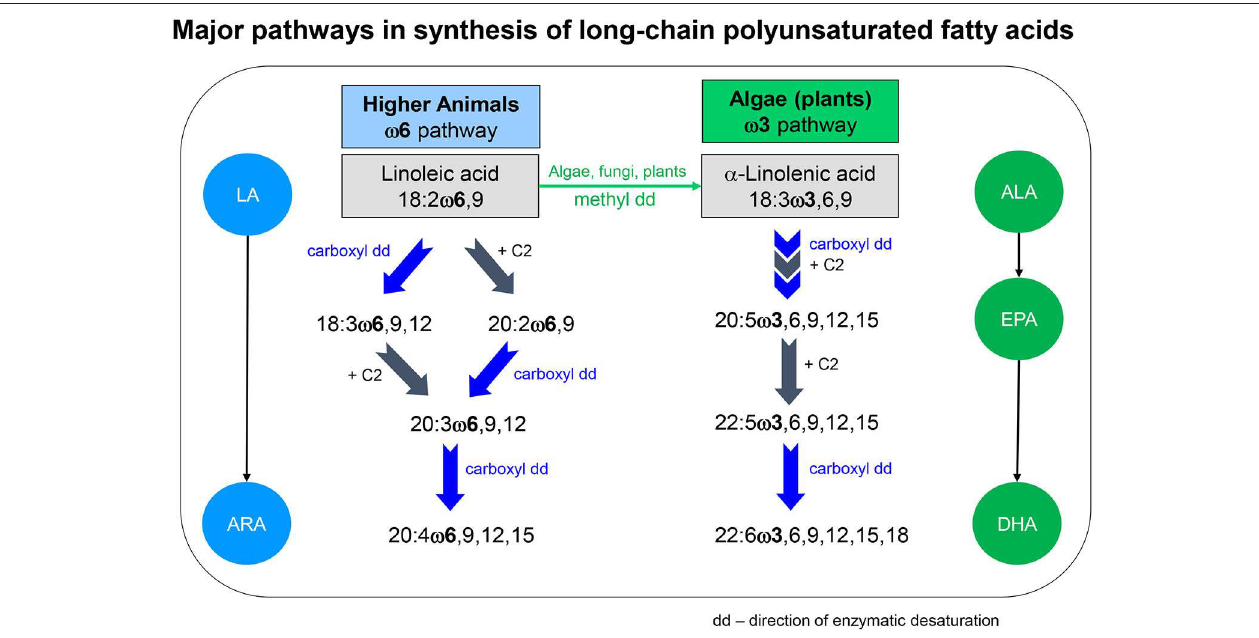
FIGURE 1 | Major pathways in synthesis of long-chain polyunsaturated fatty acids (LC-PUFA) in eukaryotic organisms (modified after Sprecher et al., 1995). LA, linoleic acid; ALA, α -linoleic acid; ARA, arachidonic acid; EPA, eicosapentaenoic acid; DHA, docosahexaenoic acid; dd, direction of the enzymatic desaturation in the fatty acids molecule; methyl-end desaturases introduce double bonds in C 16 - and C 18 -FA at ω 3 and ω 6 position, animal desaturases work toward the carboxyl-end beyond the ω 6